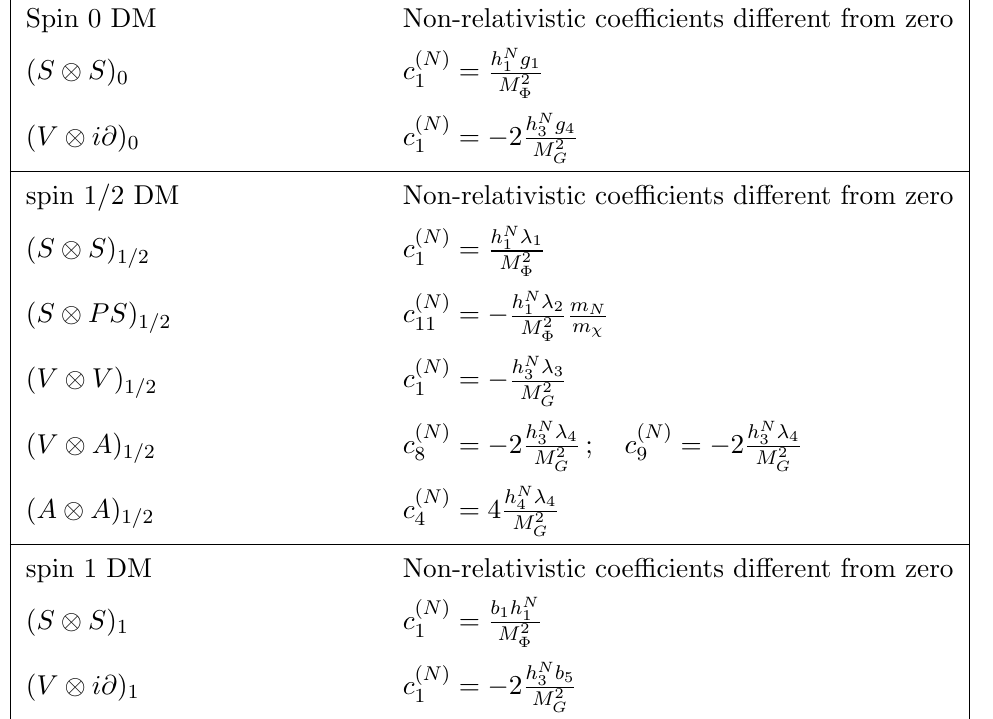
Table 1 . Relation between the coupling constants of non-relativistic operators from table 2 (in the proton/neutron basis) and simpli(cid:12)ed models in this study (see eq. (2.1) and appendix A for their Lagrangians). In the case of spin 1 DM, we do not consider non-relativistic operators that depend on the symmetric combination of polarisation vectors denoted by S in table